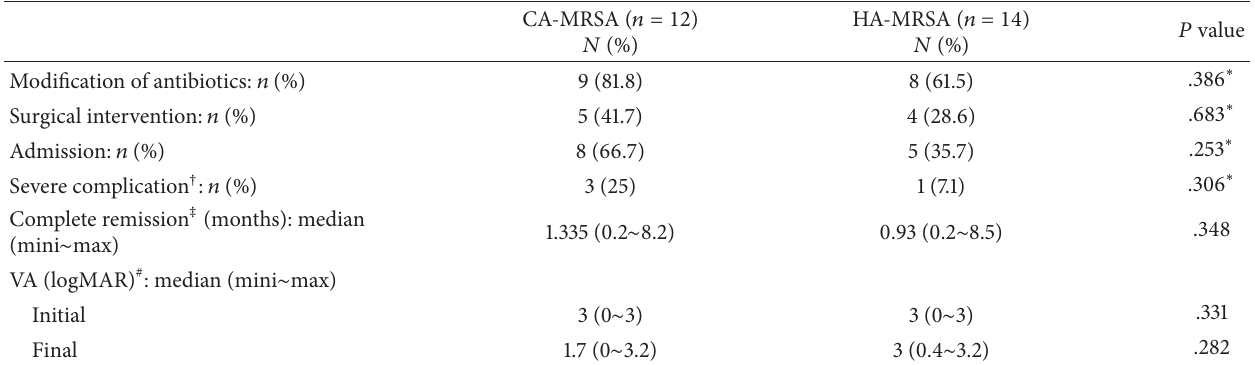
Table 5: Treatment and clinical outcome of community-associated methicillin-resistant Staphylococcus aureus (CA-MRSA) and healthcare- associated methicillin-resistant Staphylococcus aureus (HA-MRSA)